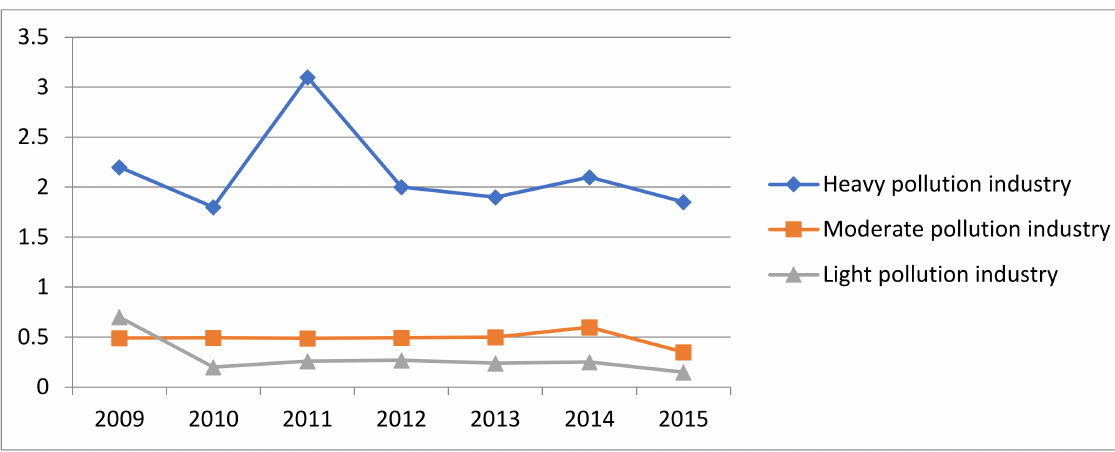
Figure 3. Average regulation intensity of the three major categories of pollution